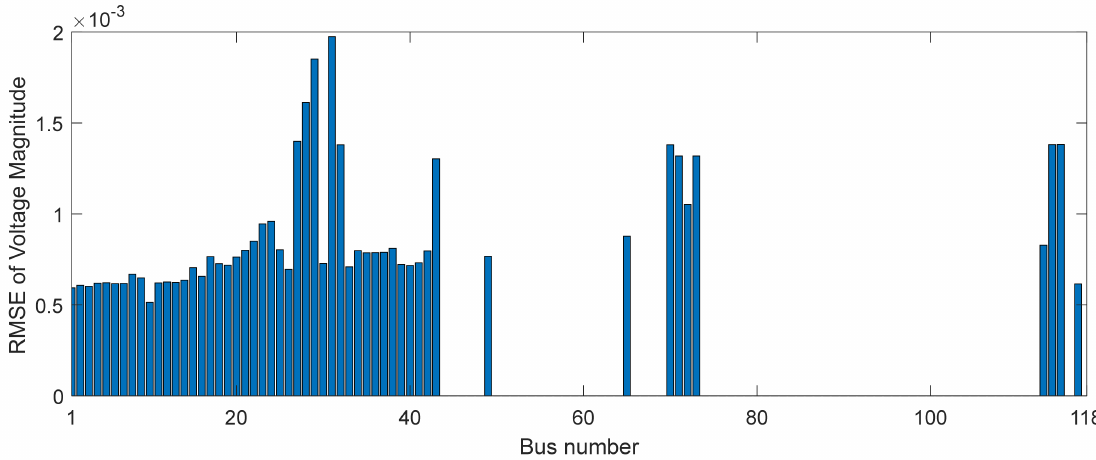
Figure 6. RMSE of bus voltage magnitude with bus-to-ground fault at bus